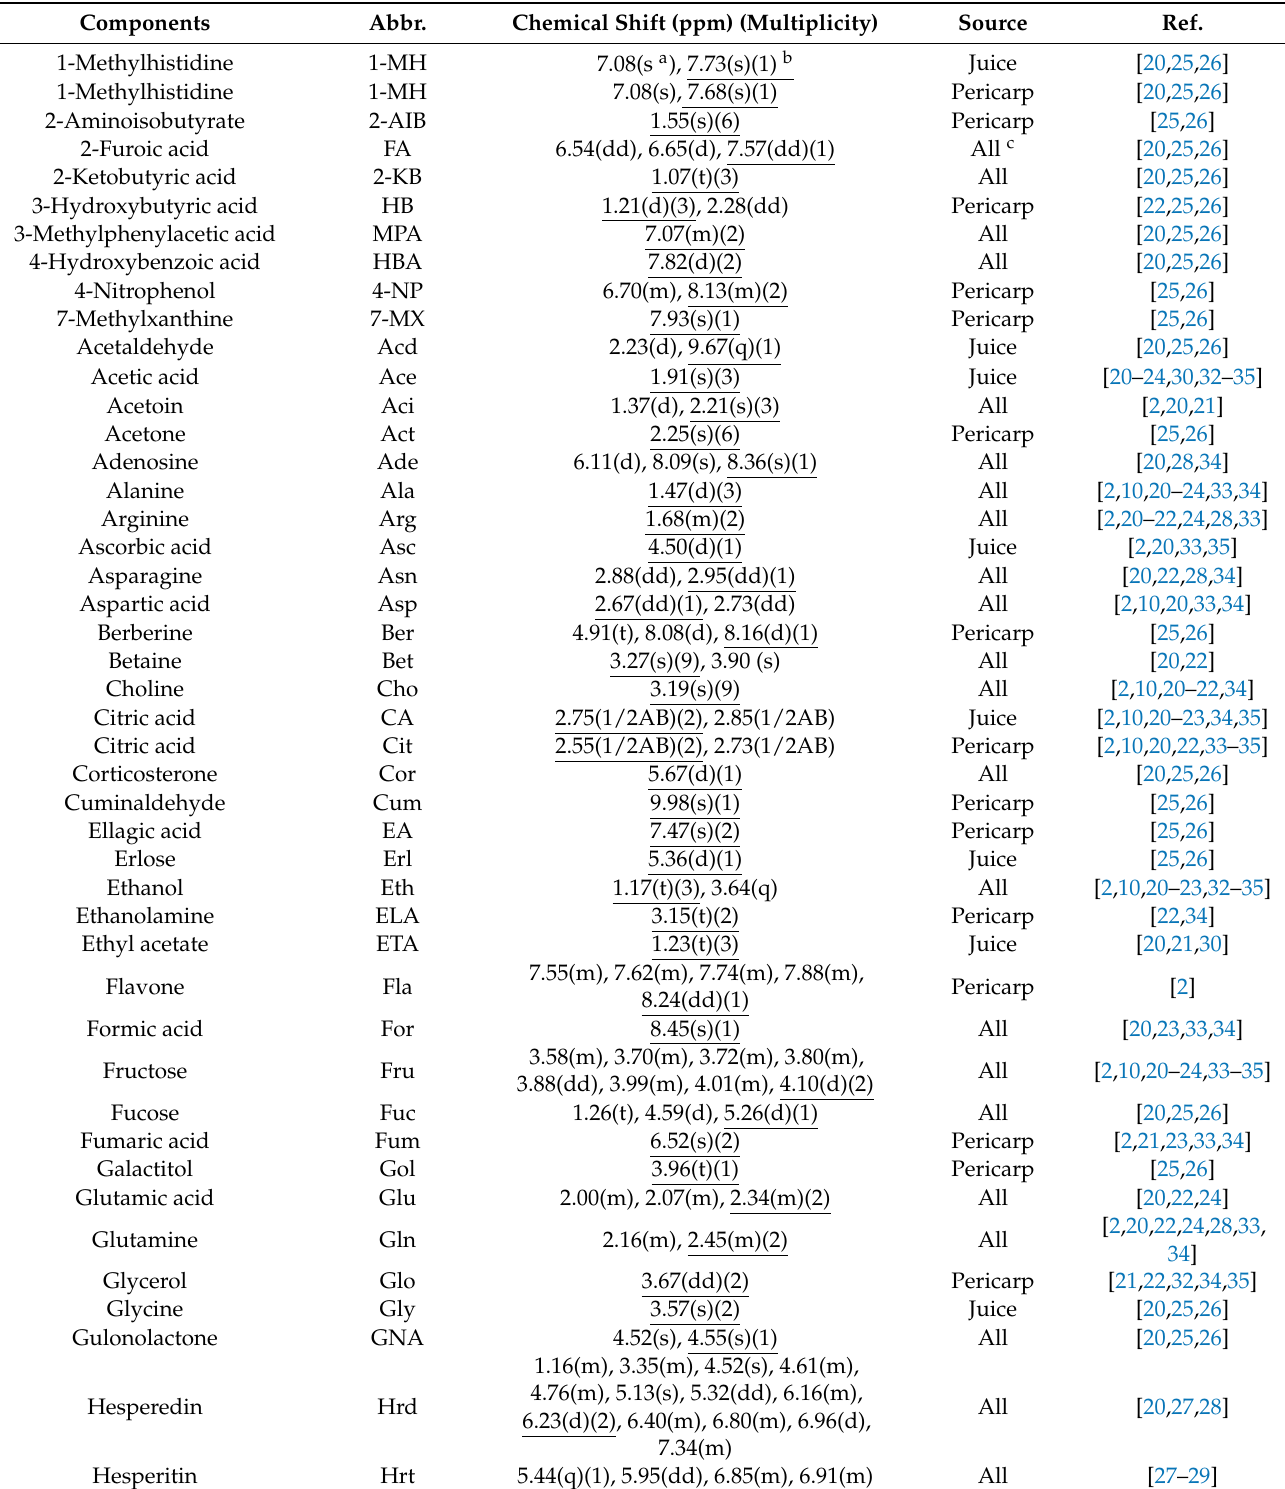
Table 1. The identified components from the NMR spectra of juices and pericarps of four varieties of